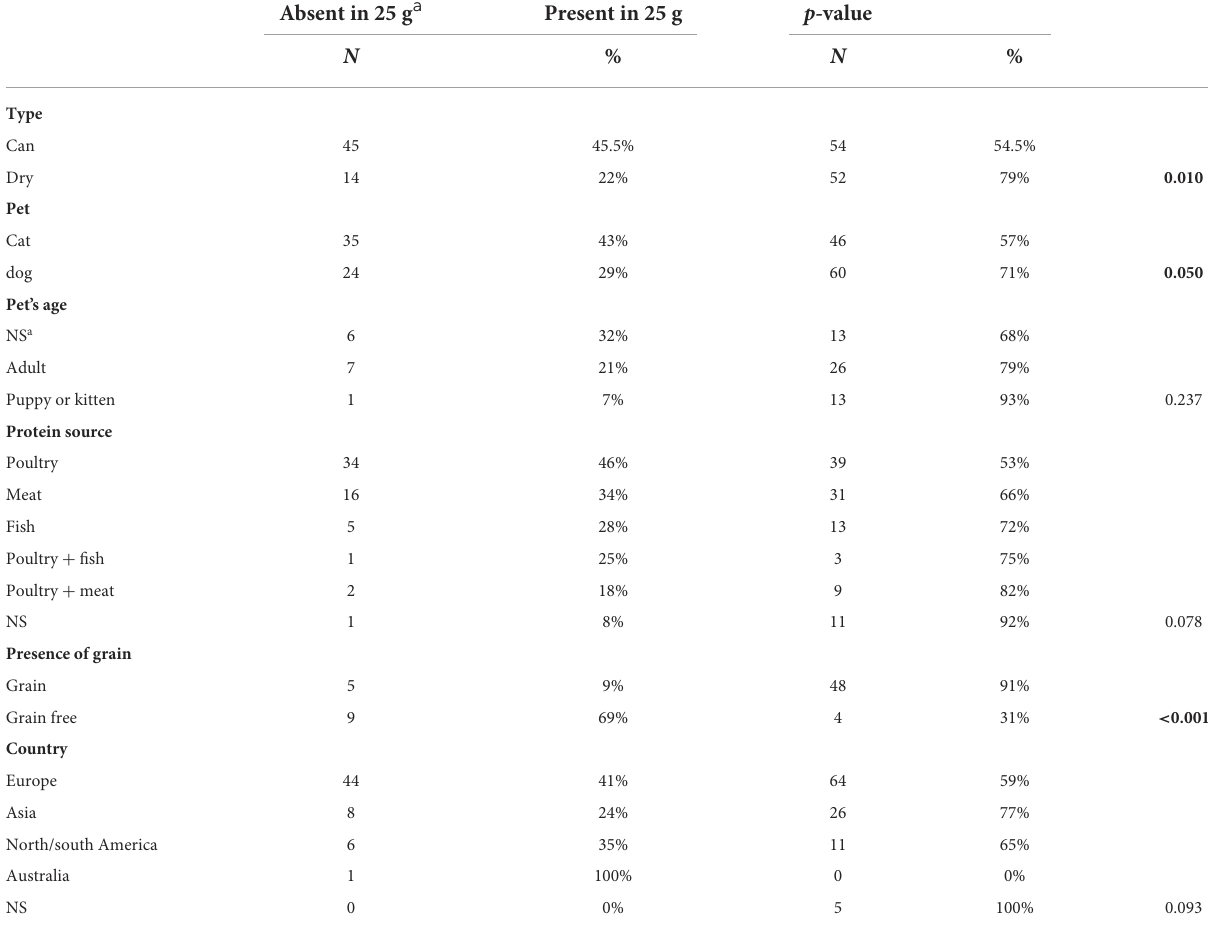
TABLE 5 Microbiological results of presumptive Listeria spp. in dry and canned pet food. Absent in 25 g